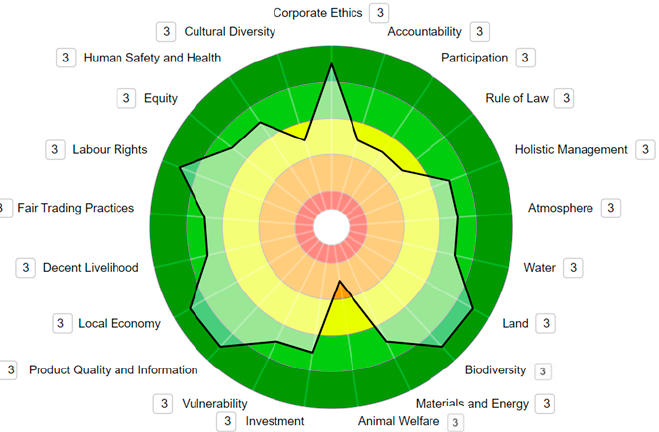
Figure 11. SAFA assessment result of the start ‐ up as spider graph. The number near indicators sug ‐ gest the data quality according to Table 4, and also, the colour in the circles represent the range score. As reported in Table 3, the colour means the performance score: Dark green: Best; light green: Good; yellow: Moderate; orange: Limited; red: Unacceptable. The presented business plan resulted in overall high scores linked to environmental and management indicators, while limited scores were obtained regarding social participation and stake-holder